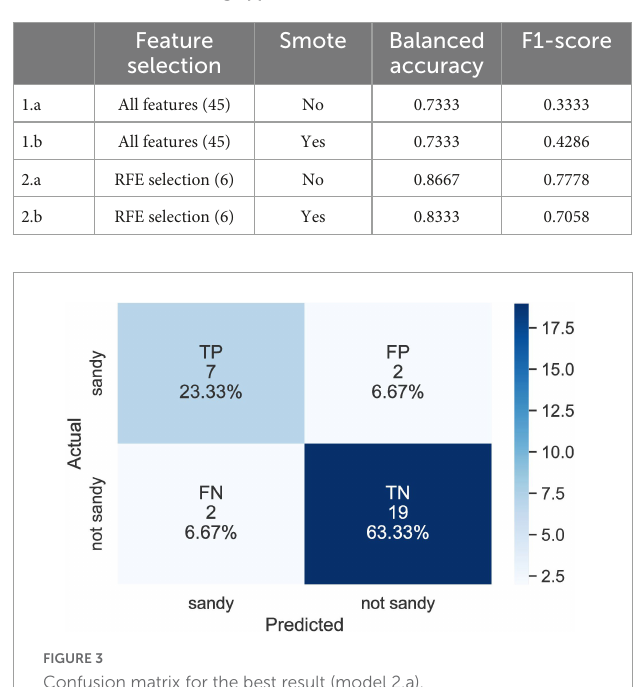
FIGURE3 Confusion matrix for the best result (model 2.a).